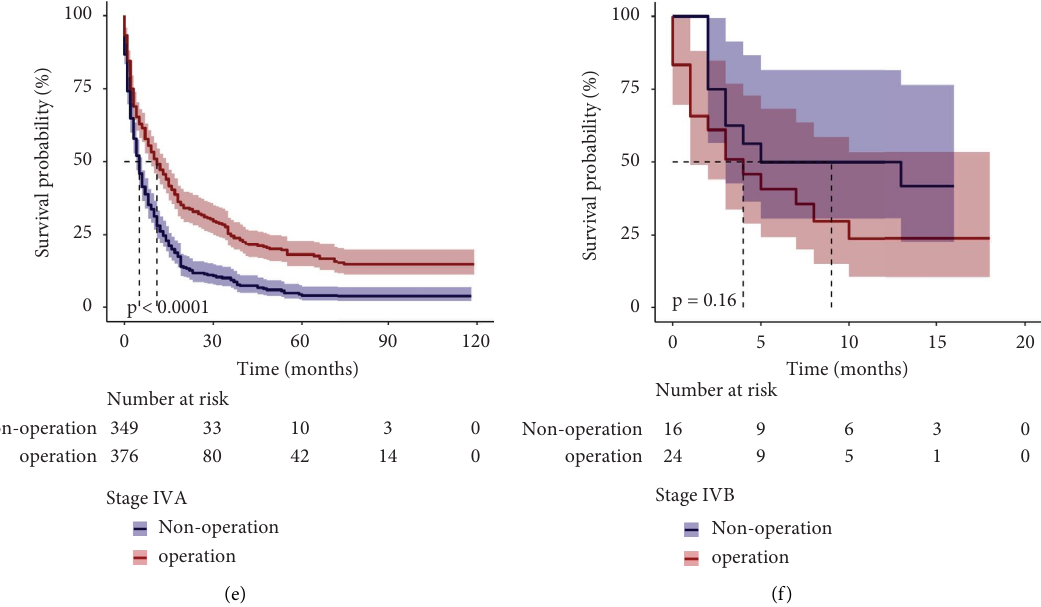
Figure 2: Kaplan − Meier plots for overall survival. (a) Entire cohort; (b) stage IIIA; (c) stage IIIB; (d) stage IIIC; (e) stage IVA; (f) stage